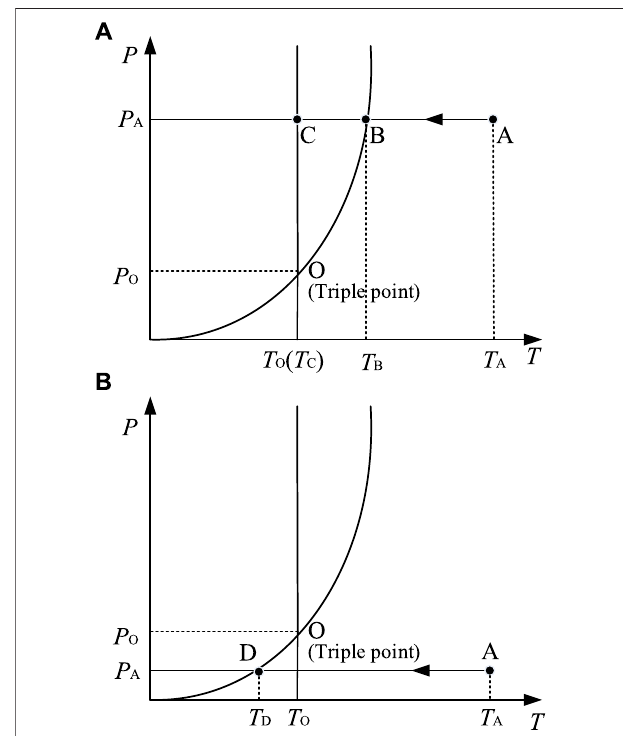
FIGURE 1 | The state change of water vapor in the air shown in the three-phase diagram: (A) the partial pressure of water vapor in the air greater than the triple-point pressure; (B) the partial pressure of water vapor in the air less than the triple-point